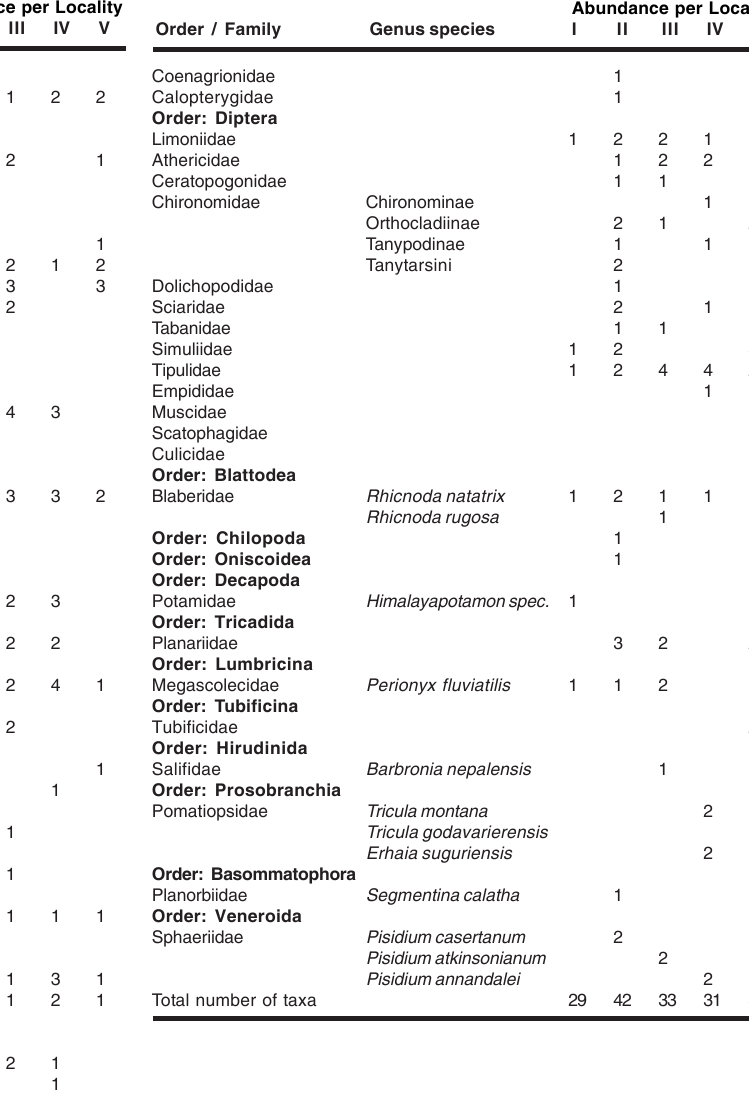
Table 3. Macro-invertebrate fauna of different Rhicnoda -habitats in Nepal Order /